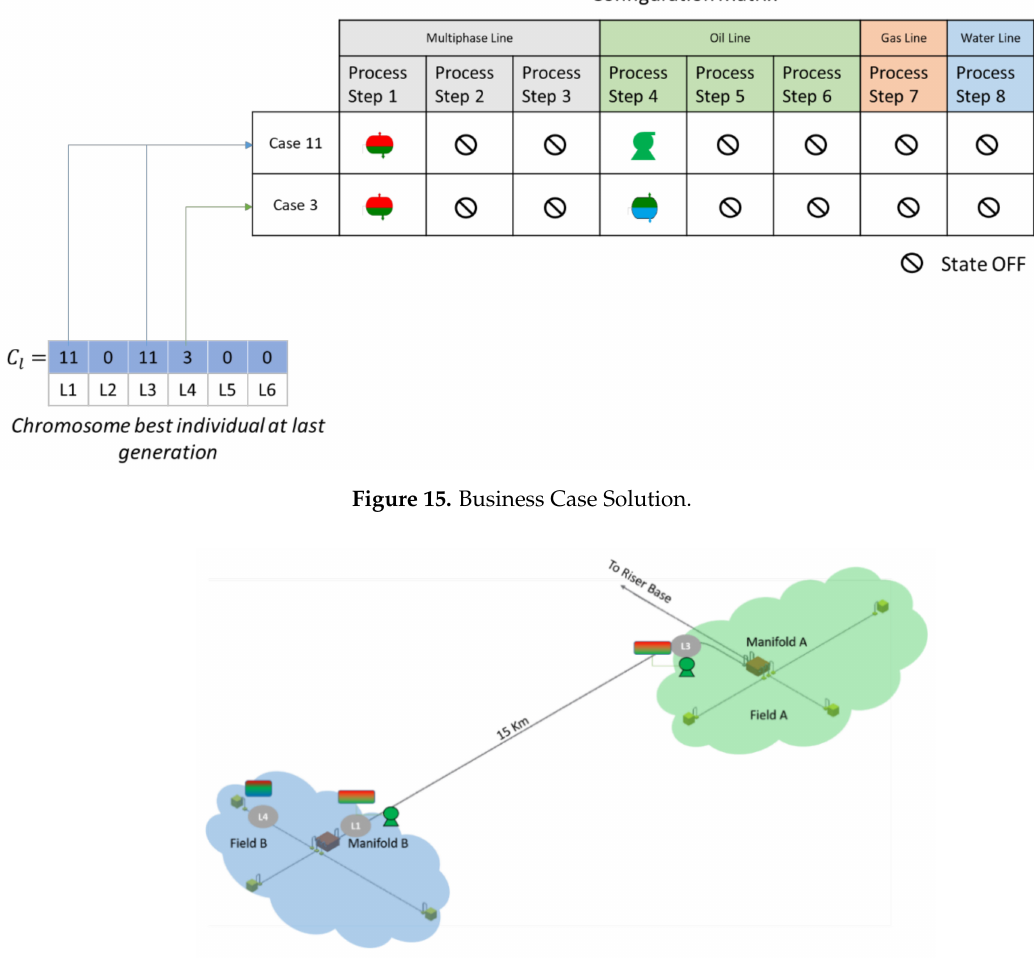
Figure 16. Selected